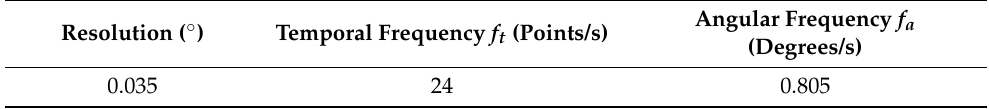
Table 1. LiDAR’s parameters during the field data